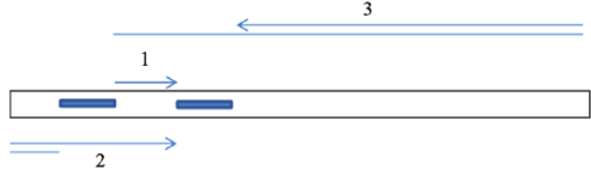
Figure 8: Wave propagation